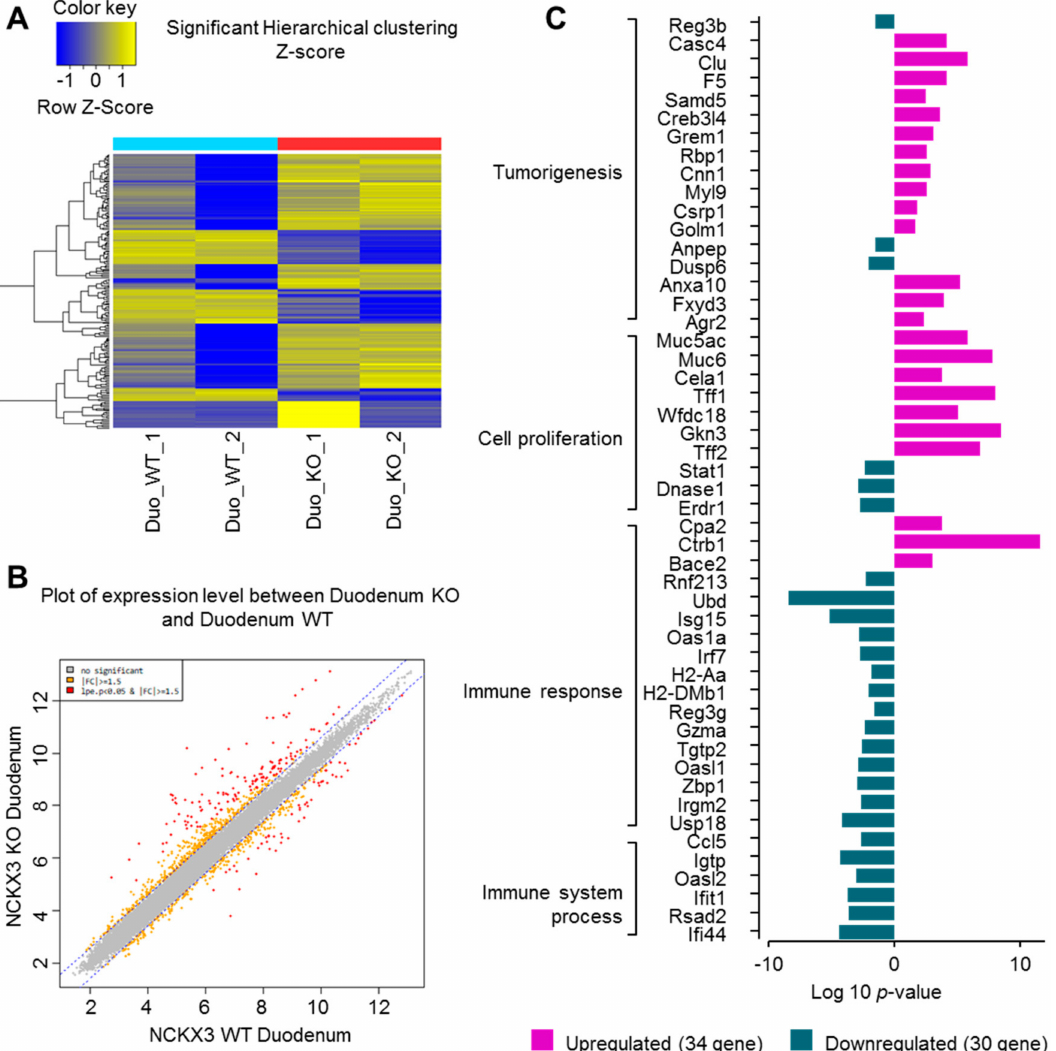
Figure 1. Gene expression profile in duodenum upon the genetic deletion of Nckx3 locus. mRNA was collected from duodenum tissue of wild-type (WT) and Nckx3 knockout (KO) mice at 6-week-aged, followed by Affymetrix mRNA microarray assay: ( A ) differentially expressed mRNAs were analyzed using hierarchical clustering. ‘Blue’ indicates low relative expression and ‘yellow’ indicates the high relative expression, and ‘blue’ indicates a low relative expression; ( B ) box plot showing the distribution of maximum, minimum, and percentile values for the normalized signal of each sample; ( C ) curated list of significantly enriched gene ontology (GO) terms in the lists of up and downregulated